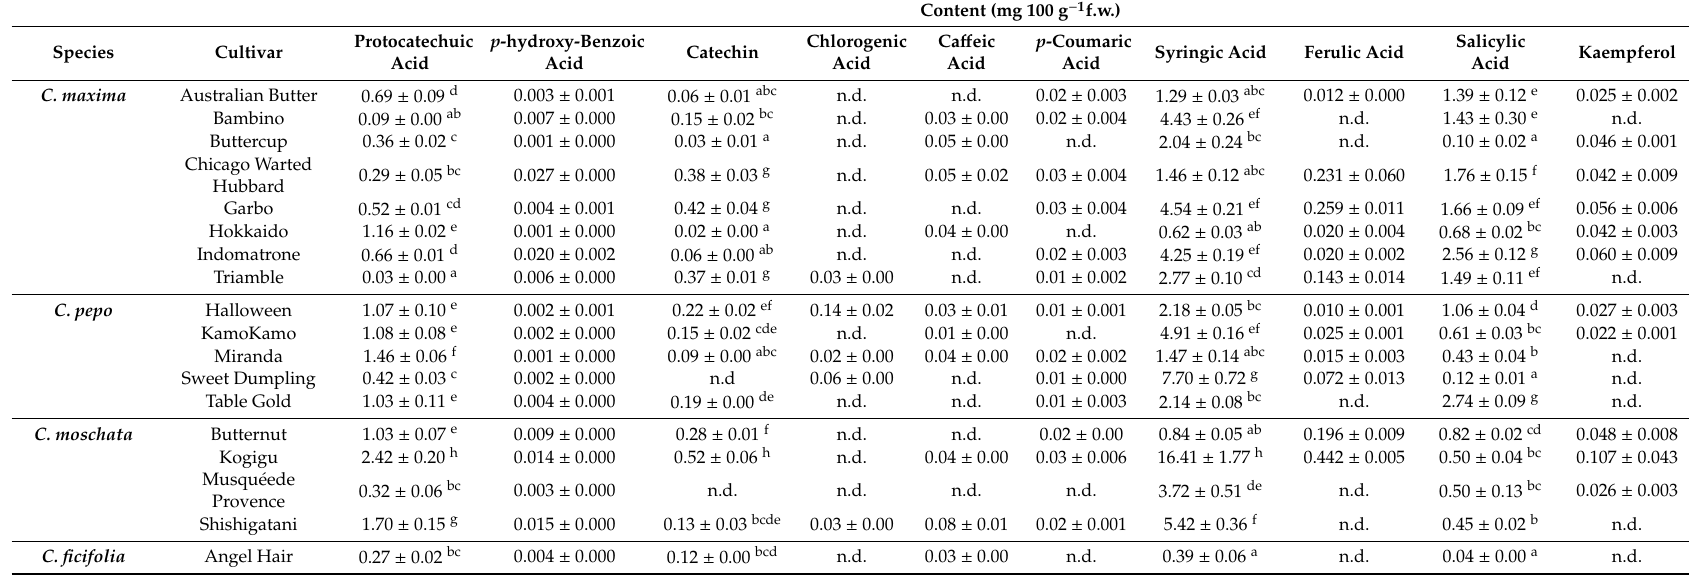
Table 2. Content of selected phenolic compounds in the pulp of 18 Cucurbita cultivars.